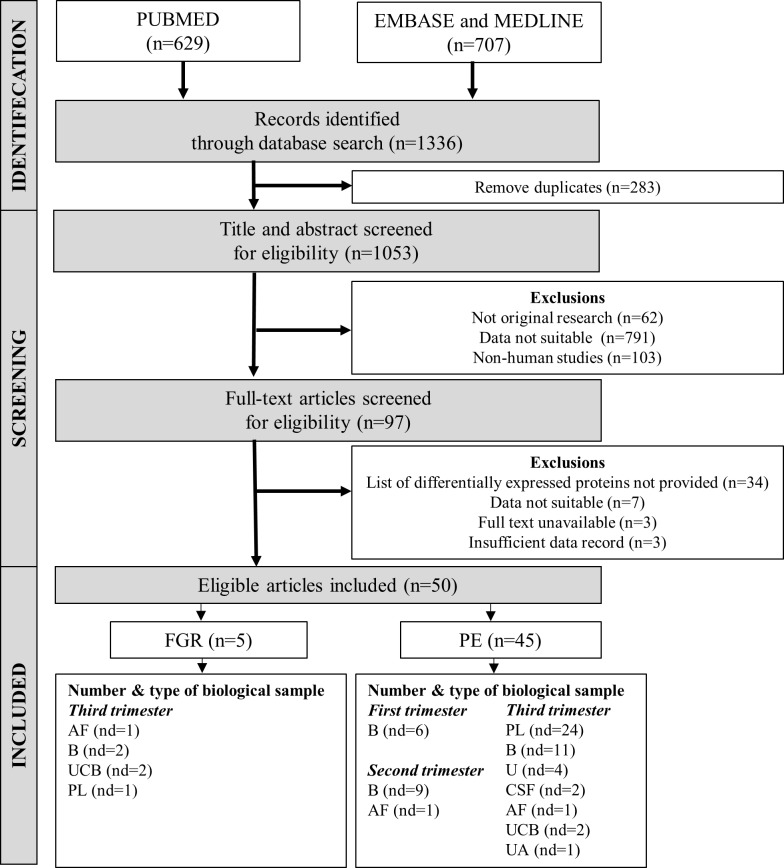
Flow chart showing electronic search strategy used to identify eligible articles for the meta-analysis.Number (n) in brackets refers to the number of articles. Number of datasets (nd) in the eligible articles were grouped according to type of biological sample and the trimester of pregnancy in which the sample was obtained. In some eligible articles, two or more different types of biological samples were used in their studies, giving rise to a total of 6 datasets for FGR and 61 datasets for PE. Abbreviations: AF—Amniotic fluid, B—Blood, CSF–Cerebrospinal fluid, PL–Placenta, U–Urine, UA- Umbilical artery, UCB–Umbilical cord blood.